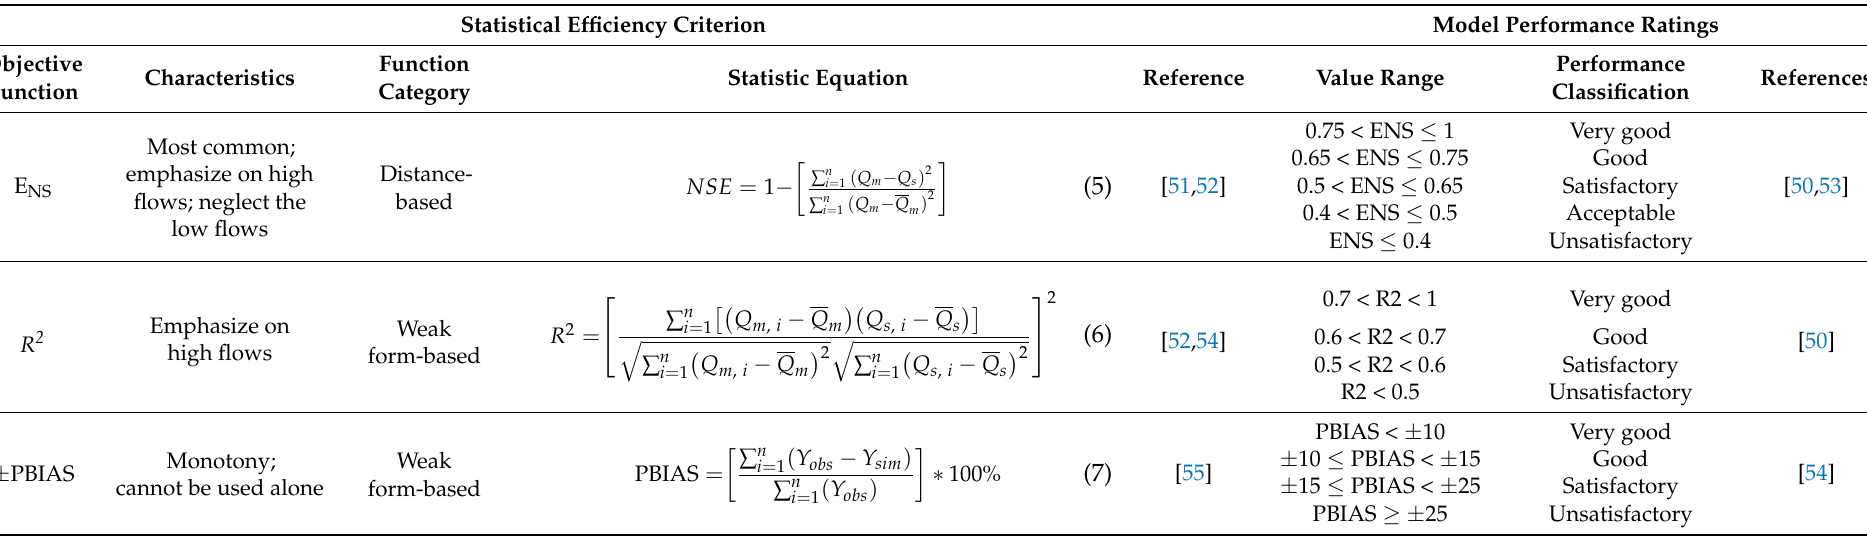
Table 2. Classical objective functions, characteristics, function category, equatio n, and performance classification